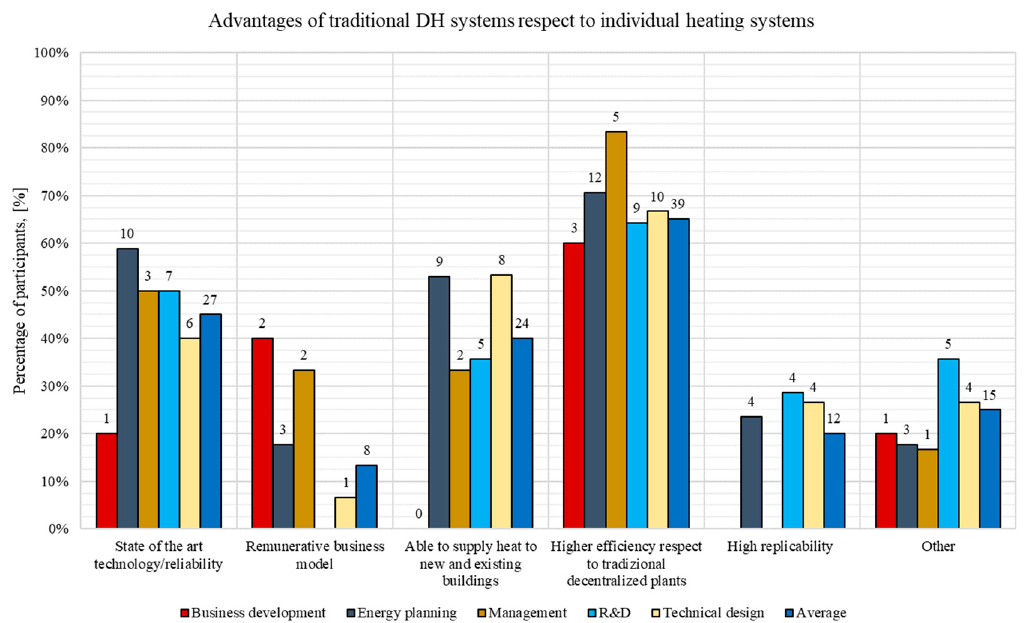
Figure 15. Advantages of traditional DH systems with respect to individual heating systems as a function of the employment role.